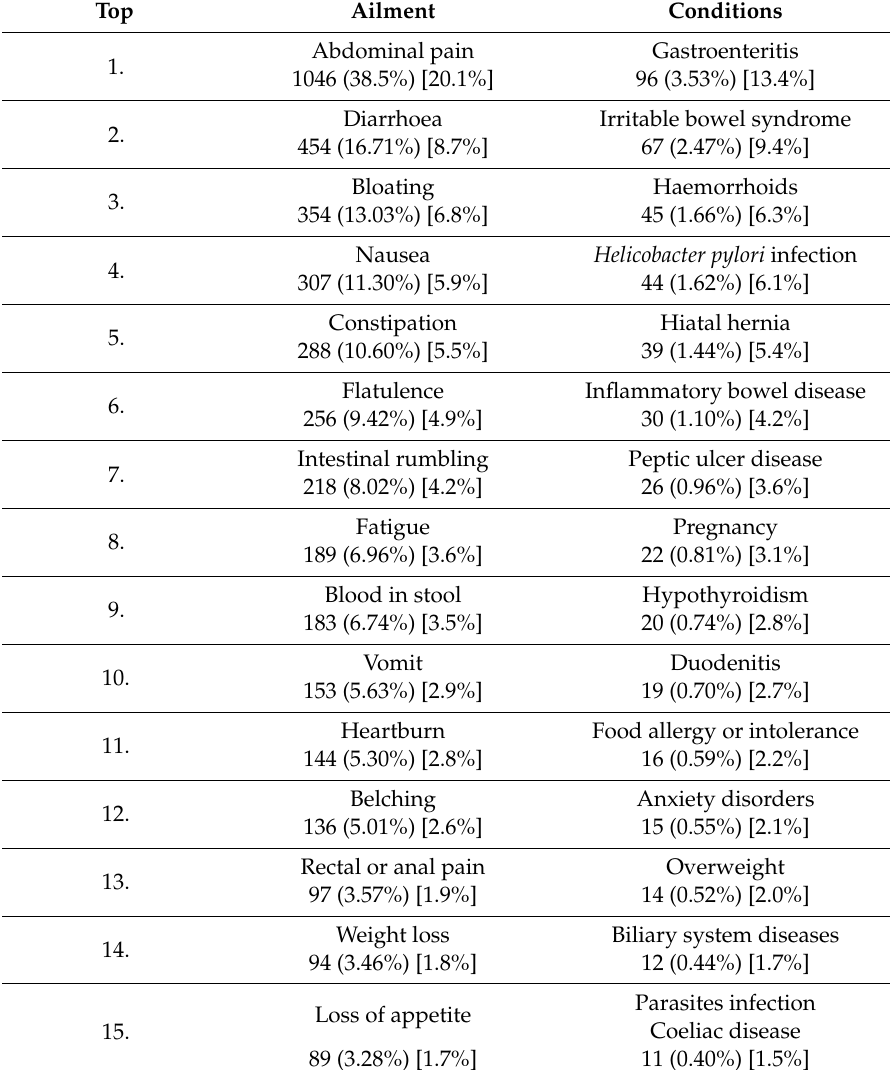
Table 1. The most prevalent declared ailments and conditions on the gastroenterology section of the Polish Internet forum for anonymous